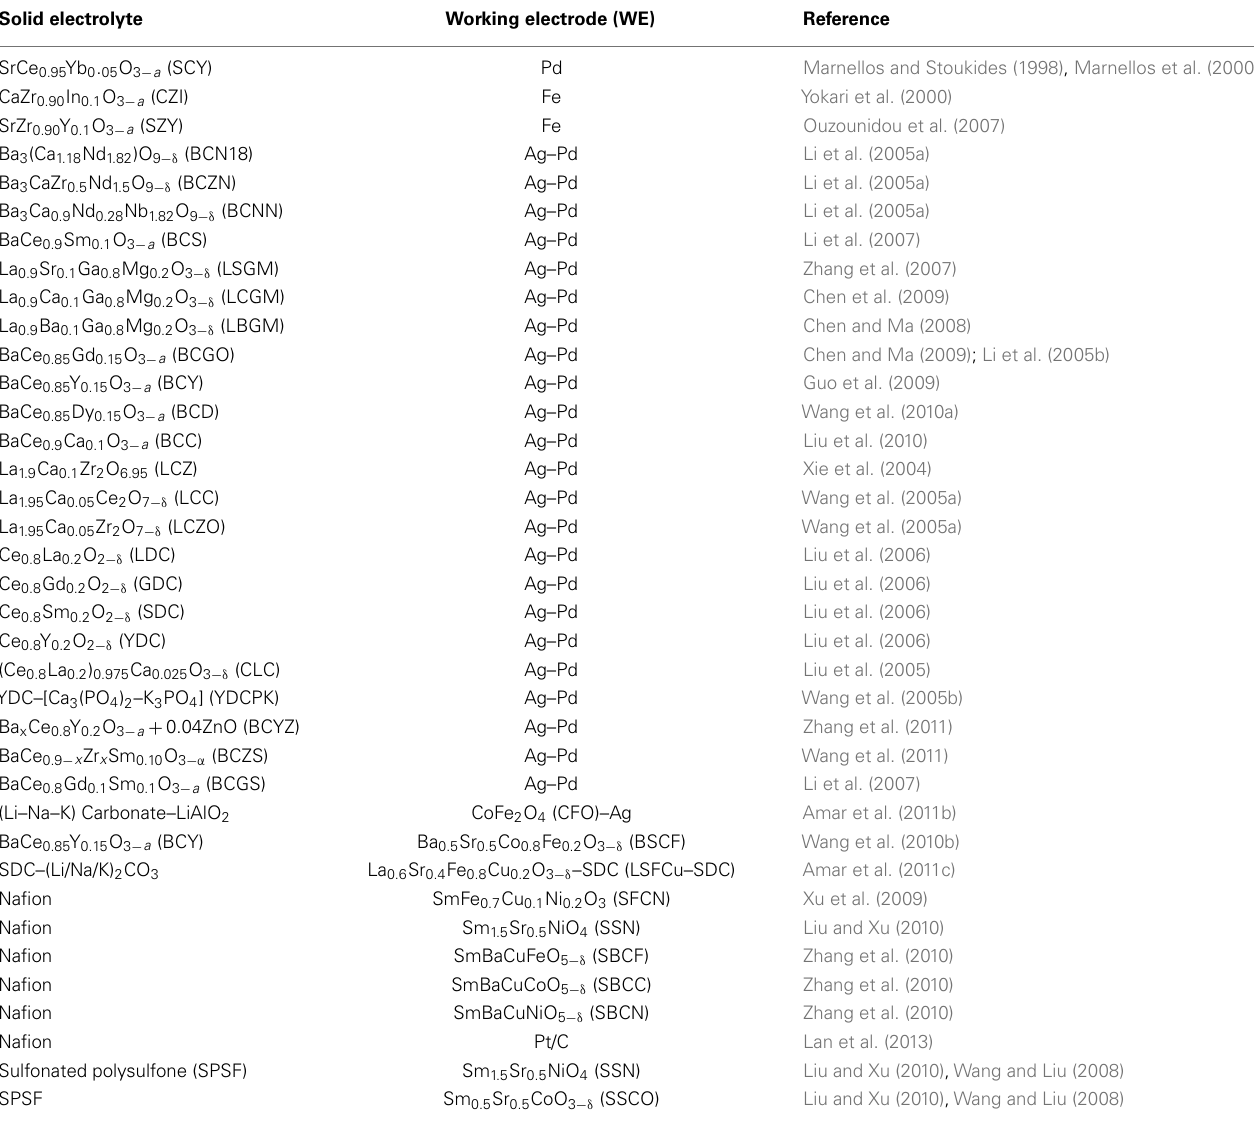
Table 1 |The proton-conducting electrolytes and electrodes used by various investigators in solid state ammonia synthesis cells. Solid electrolyte Working electrode